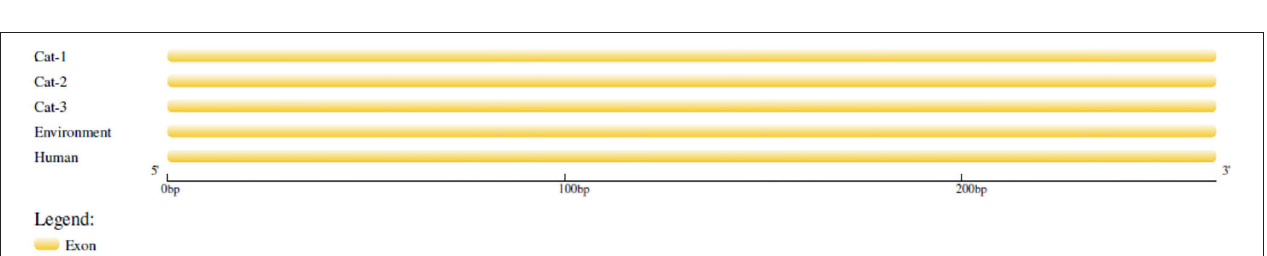
FIGURE 7 | mecA protein motifs of Staphylococcus aureus .